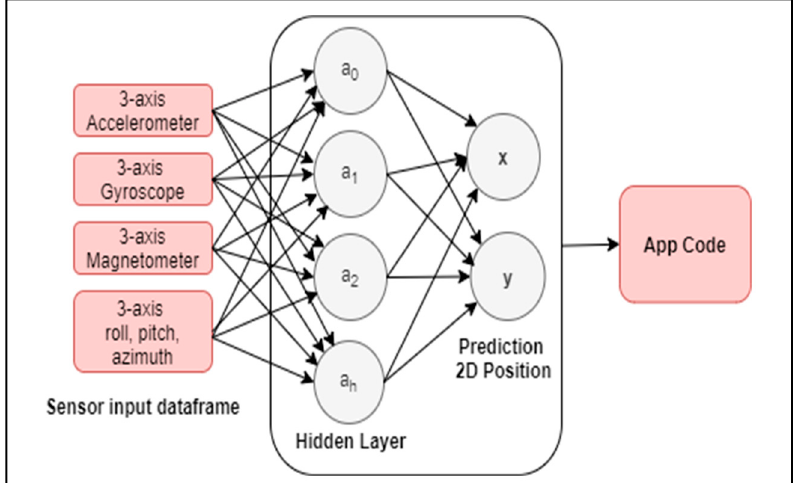
Figure 6. MPL network structure for the prediction of x and y position for indoor navigation by [99].